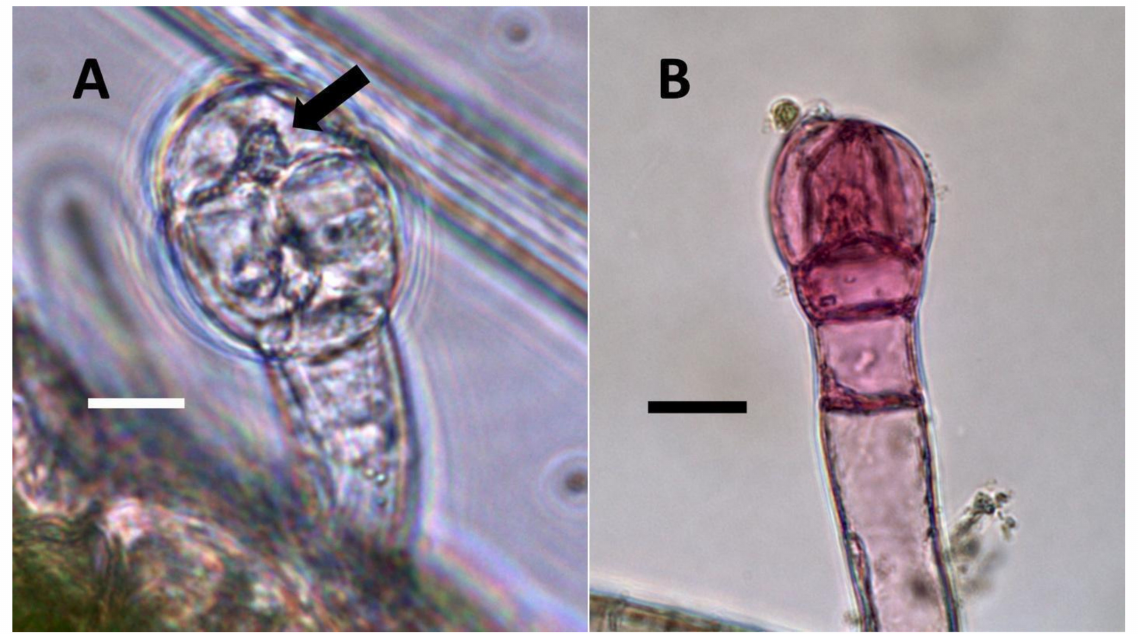
Figure 12. Rhus glabra seedling leaf trichomes stained for nitric oxide using iron sulfate. ( A ) Non- sterilized seedling trichome stained with iron sulfate to show nitric oxide (brown color) around bacteria (arrow) internally (Bar = 10 µ m). ( B ) Trichome on seedling developed from surface-sterilized seeds stained with iron sulfate showing smaller size and absence of nitric oxide staining internally. The pink color may be due to anthocyanins or other pigments (Bar = 10 µ m).